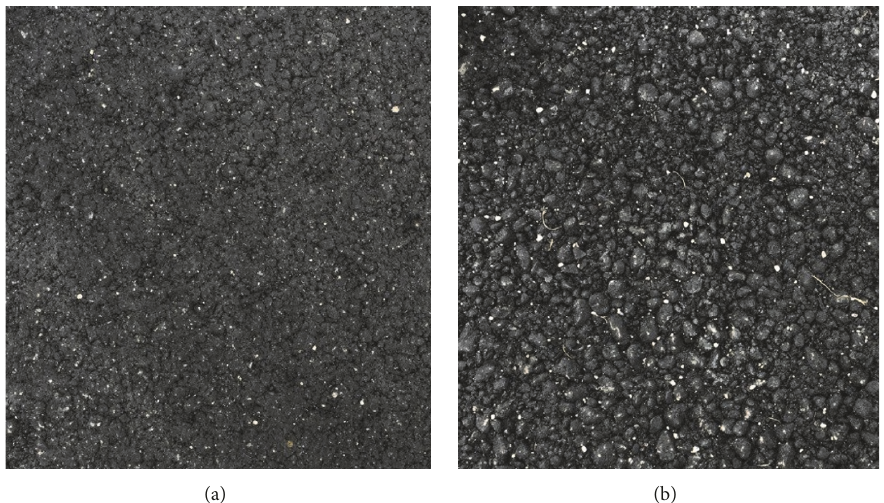
Figure 4: (a) Nonsegregated asphalt surface image and (b) segregated asphalt surface image.